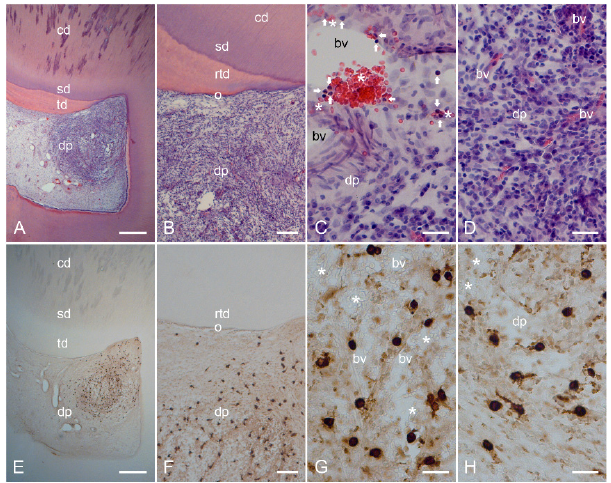
Figure 2. Histopathological characterization of inflamed human dentin–pulp complex by hematoxylin and eosin (HE) staining and the expression of mast cell tryptase (MCT) in cells from consecutive sections of inflamed human dental pulp. In deep dentin caries of the dentin–pulp complex, the carious dentin lesion sites (cd) with destroyed primary dentin, secondary dentin (srd), and the formation of reactive tertiary dentin (rtd) are visible ( A ). The structural and cellular order of the healthy dentin–pulp complex is not visible in the carious dentin–pulp complex ( A , B ). Beneath the carious lesion, there are severe chronic and acute inflammatory areas with numerous different inflammatory cells and dilated blood vessels ( B – D ). Neutrophilic granulocytes (arrows) associated with numerous erythrocytes (asterisks) are found in the lumen and wall of the blood vessels ( C ). In the consecutive section of the inflamed human dental pulp, MCT is detected in mast cells within chronically and acutely inflamed areas, which are seen in the overview ( E ) and detailed images ( F – H ). The mast cells are associated with blood vessels, which contain numerous erythrocytes (asterisks; G , H ). Scale bars: ( A , E ) = 500 µ m; ( B , F ) = 100 µ m; ( C , D , G , H ) = 30 µ